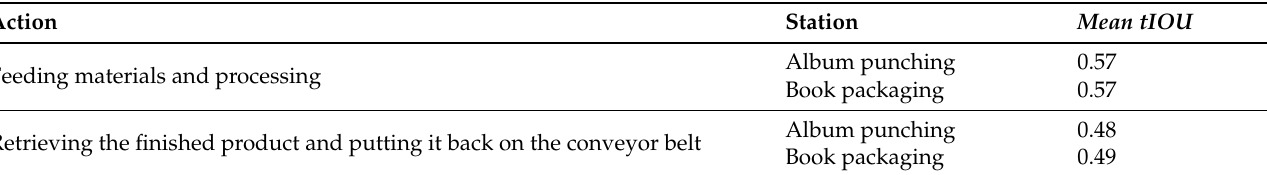
Table 1. Performance of action